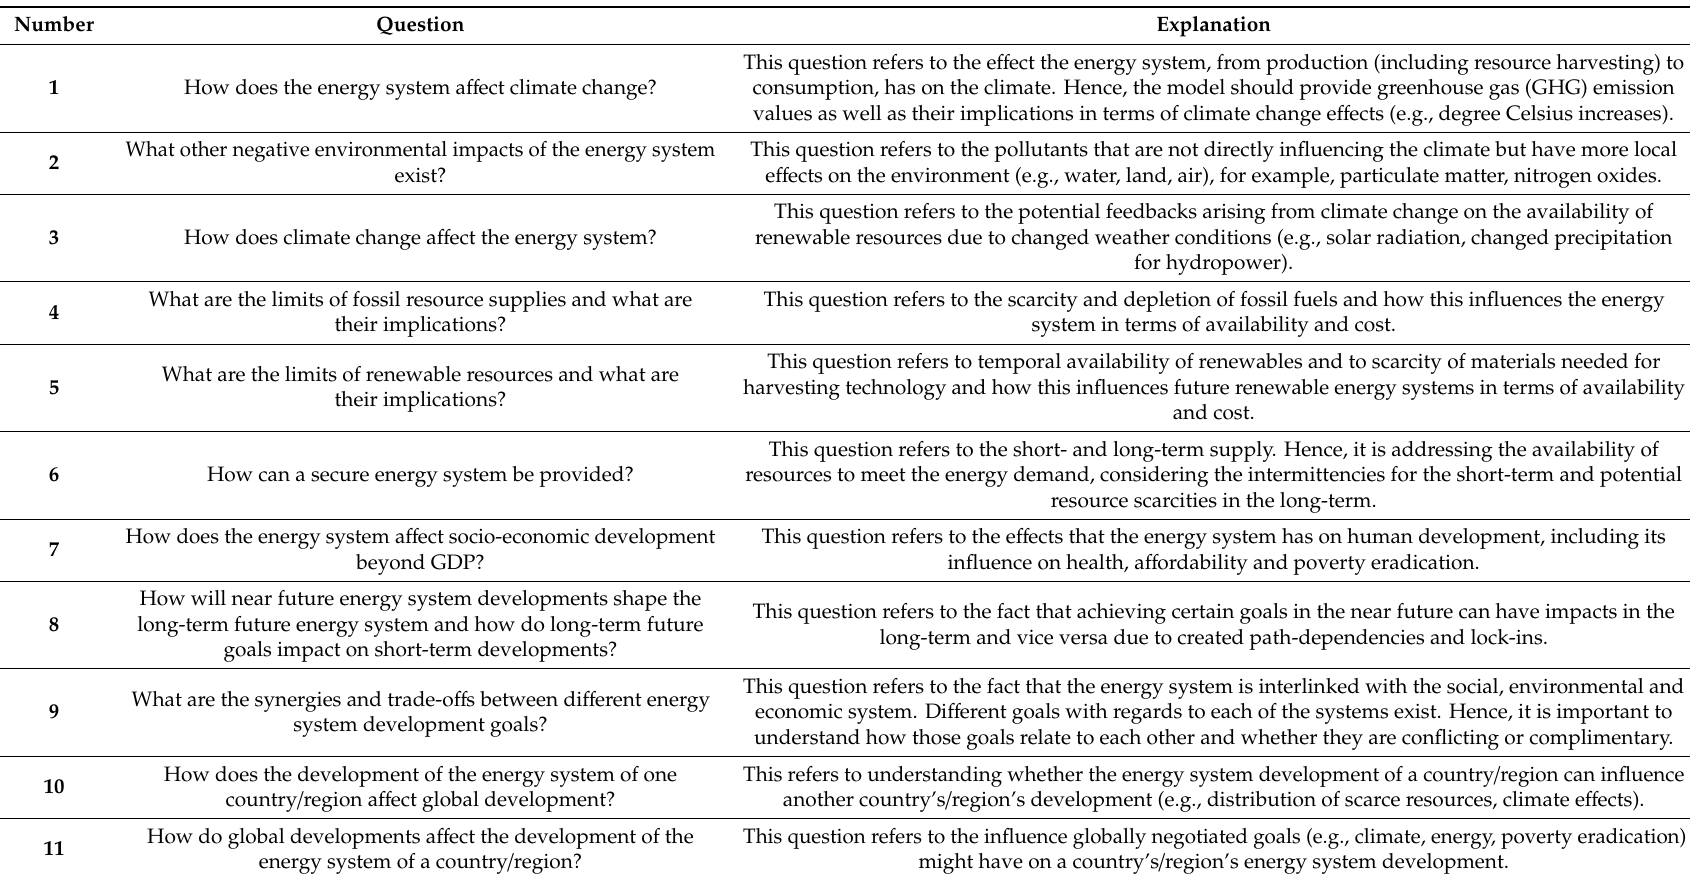
Table 2. Questions arising from the current energy